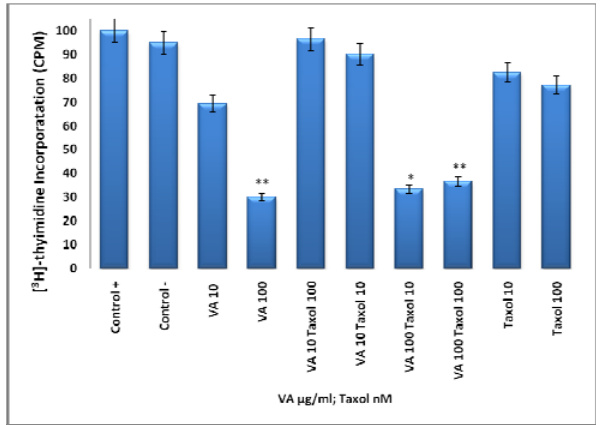
of Taxol, VA, and Combination on DNA Synthesis- Log phase proliferating cells were treated for DNA synthesis with various concentrations of VA (0-1000 µg/mL) and TAX (10, 100 Figure 4 : Genomic DNA digestion of VA with restriction nM) for 18 h followed by 6 h treatment of 1µCi/ mL [ 3 H]- enzyme BAM HI. Agarose gel electrophoresis of thymidine. Uptake was determined as described under genomic DNA samples of VA and spinach were digested materials and methods. Each data point represents the with restriction enzyme Bam HI. Bam HI cuts at mean ± SD of three independent experiments. *P<0.01; recognition sequence G ↓ **P<0.005.